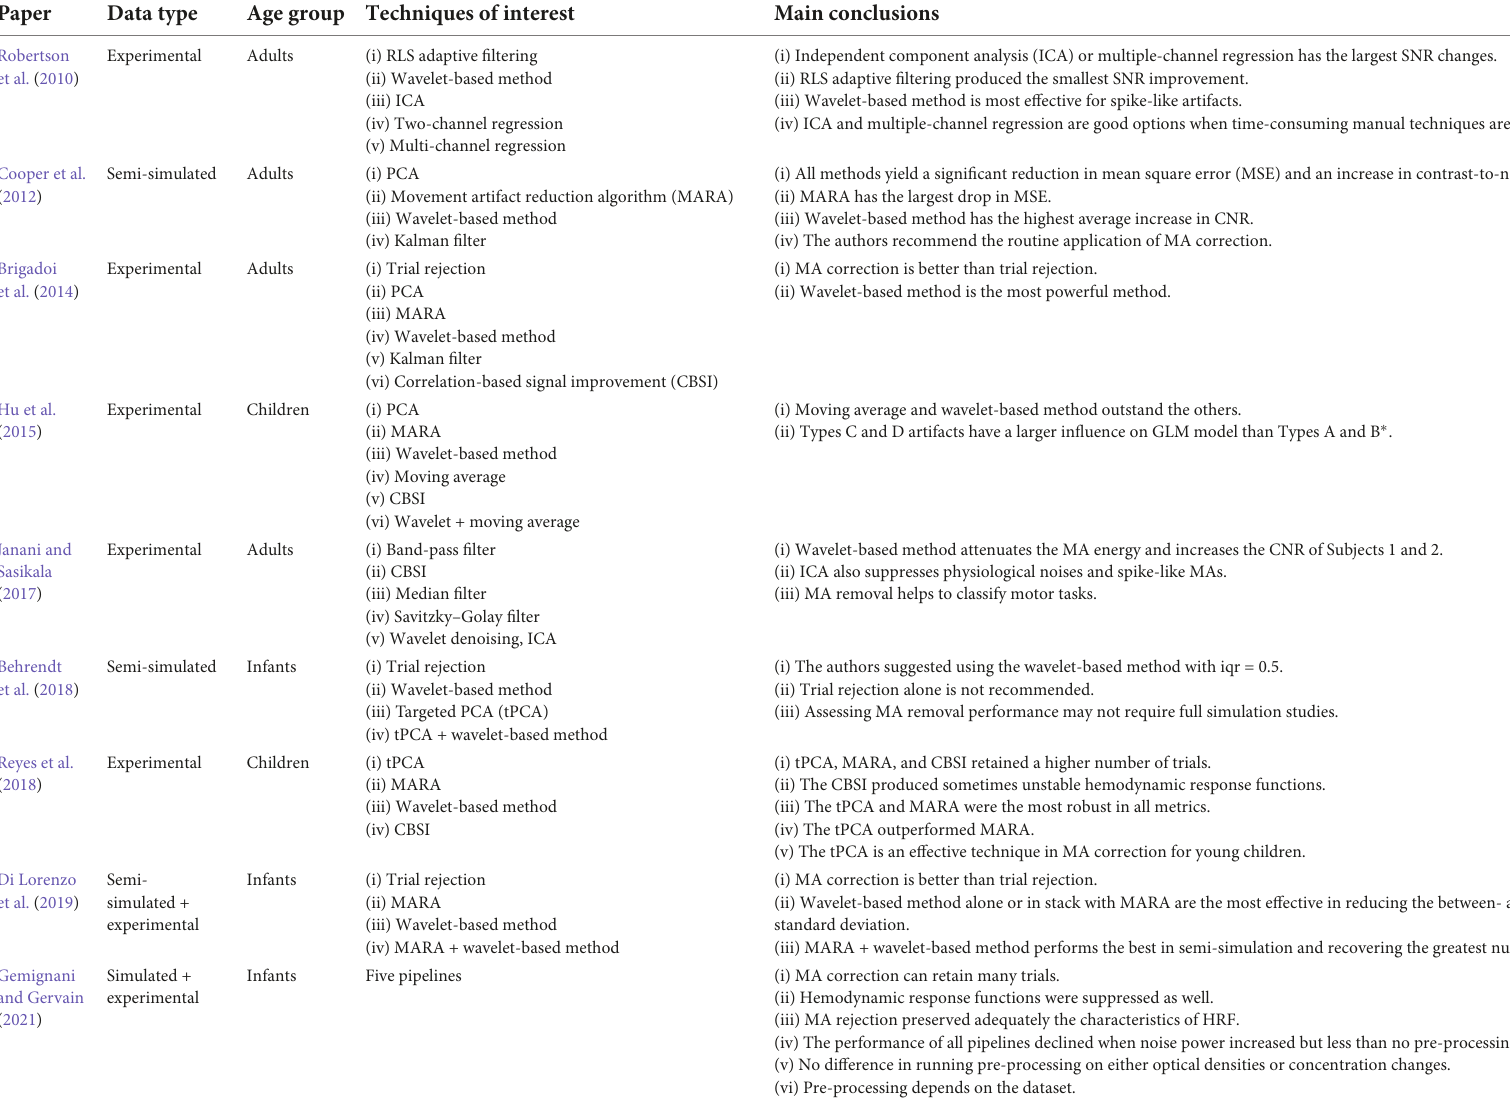
TABLE 6 Data type, age group, motion artifact (MA) removal techniques and main conclusions in the studies of MA